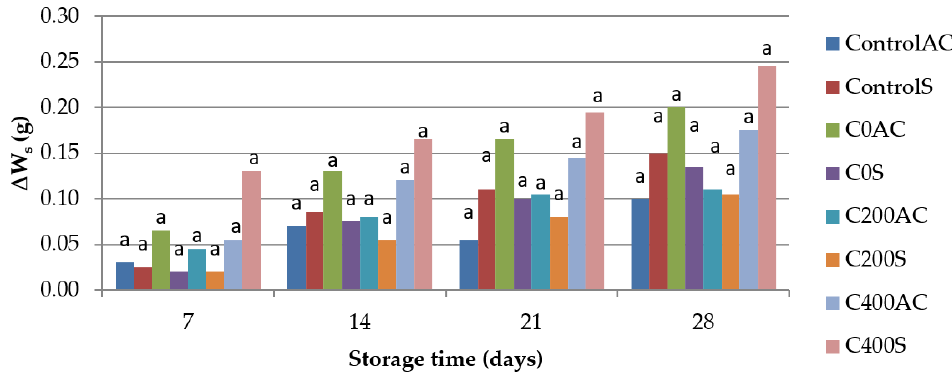
Figure 10. The effect of using sodium alginate coatings on the storage losses of weight of sausage (∆ W s ). a Means with the same letter are not different ( p < 0.05).